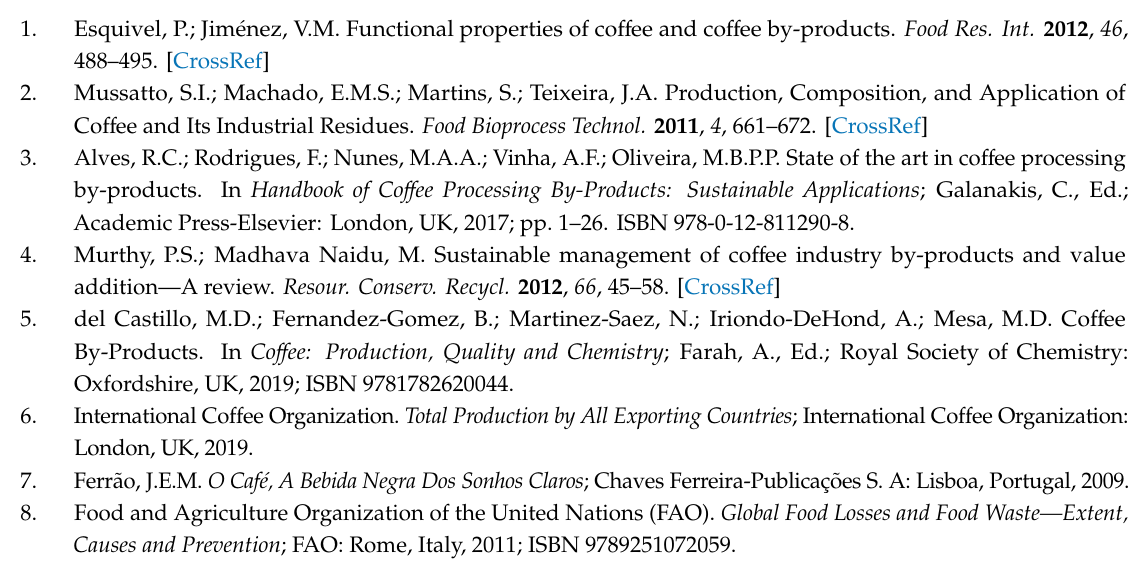
Table S1: Micronutrient recommended daily allowances (RDAs) and 15% of the RDAs. Author Contributions: Writing—original draft preparation, A.I.-D.; writing—review and editing, A.I.-D.,